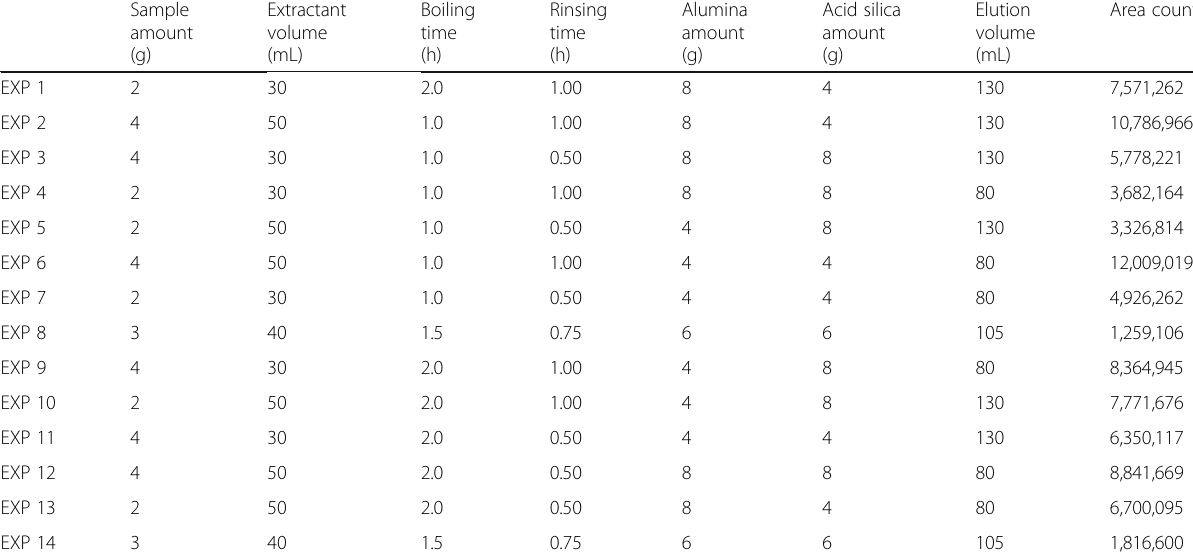
Table 2 Design matrix and response values (area counts) for Plackett-Burman factorial design Sample